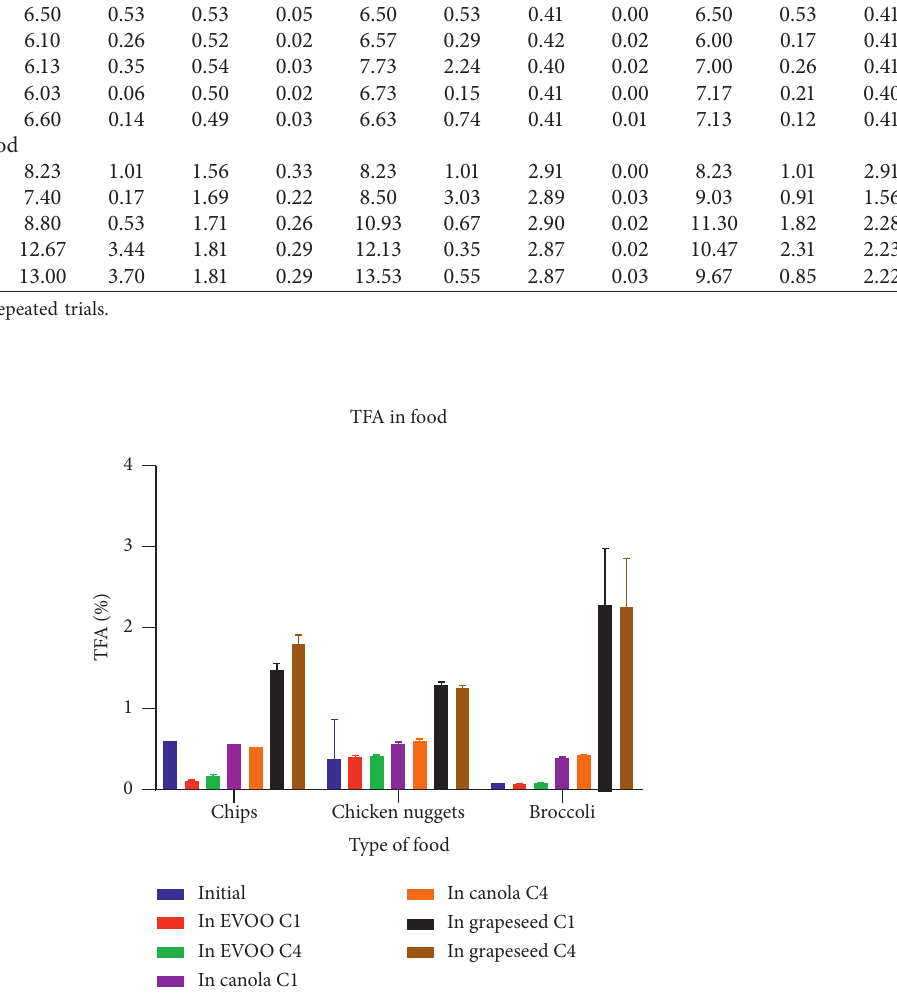
Figure 5: TFAs in food (C18:1T +C18:2T +C18 :3T) % of all